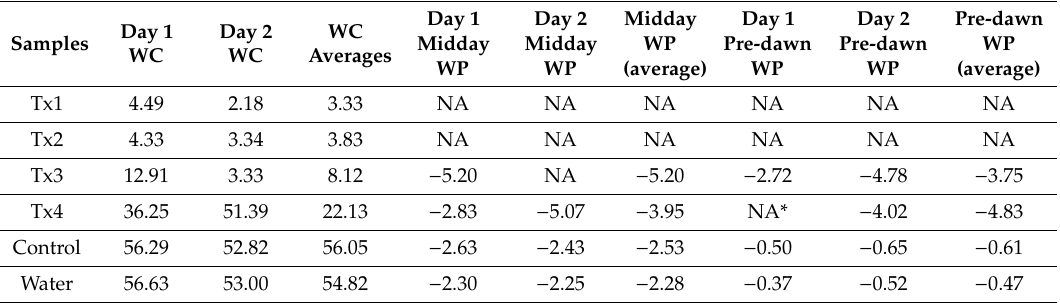
Table 2. Acquired water content (WC) and water potential (WP) samples and averages for Day 1 (25 July) and Day 2 (26 July) for each